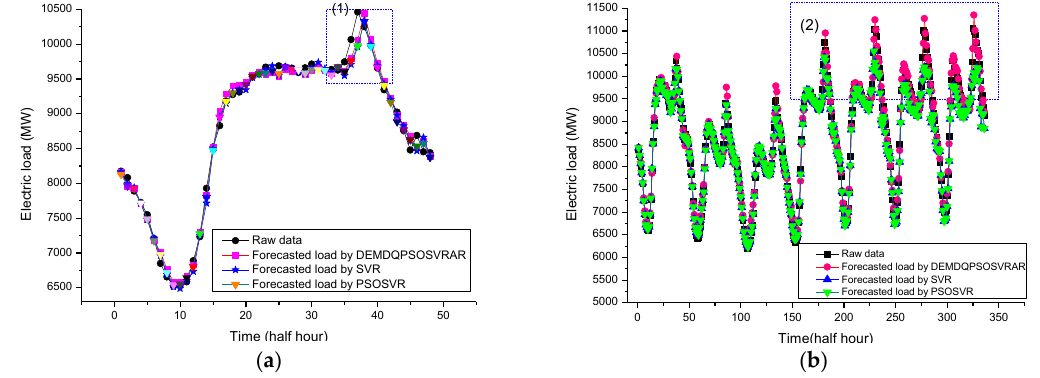
Figure 6. Comparison of the original data and the forecasted electric load by the DEMD-QPSO-SVR-AR Model, the SVR model and the PSO-SVR model for ( a ) the small sample size (One-day ahead prediction of 8 May 2007 are performed by the models); ( b ) the large sample size (One-week ahead prediction from 18 May 2007 to 24 May 2007 are performed by the models). Energies 2016 , 9 , 221